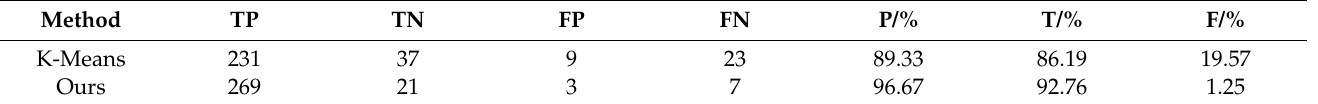
Table 9. Comparison of detection ability of different